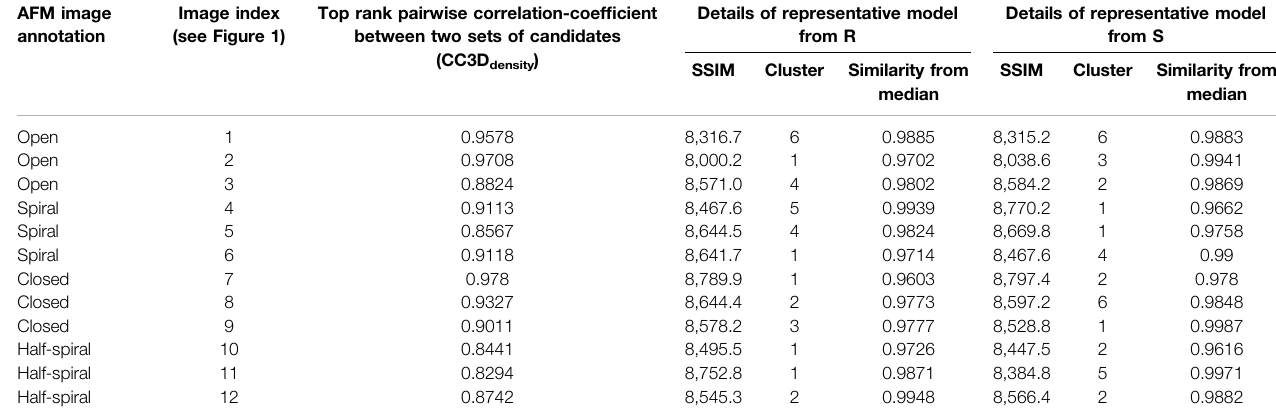
TABLE 1 | Details of representative models for AFM images of different class. AFM image Image index Top rank pairwise correlation-coef fi cient annotation (see Figure 1) between two sets of candidates (CC3D density )